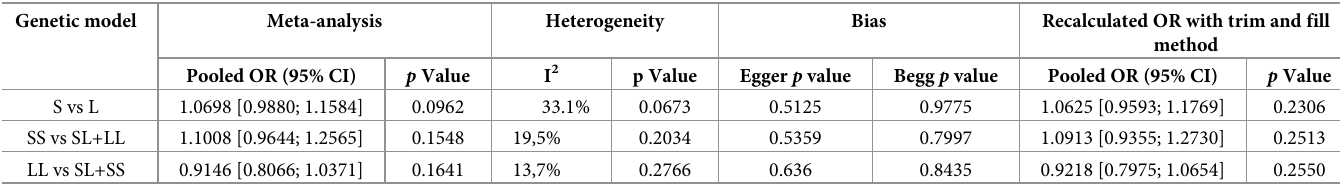
Table 4. Results of